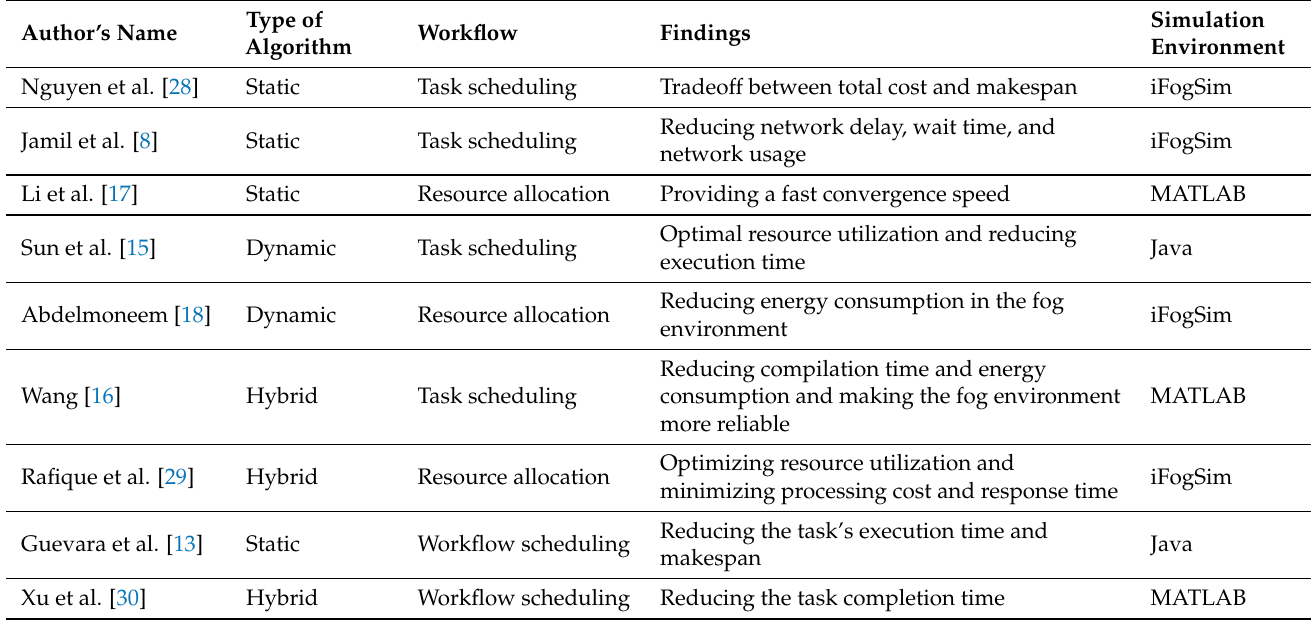
Table 1. Comparison of the existing state-of-the-art